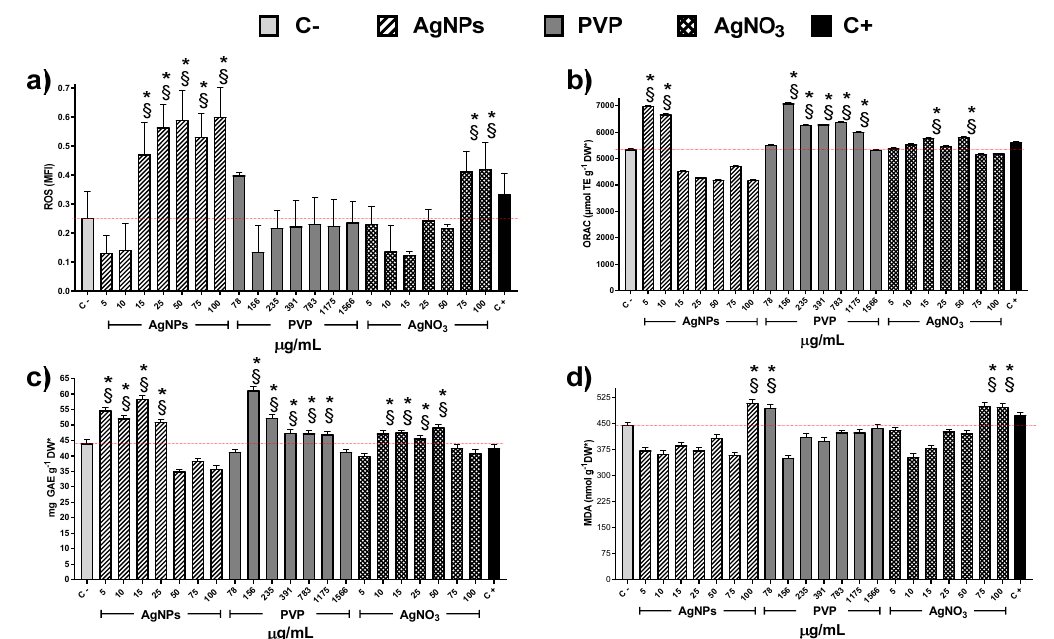
Figure 5. Antioxidant response of Allium cepa roots exposed to different stimuli. ( a ) Reactive Oxygen Species, ( b ) Oxygen Radical Absorption Capacity assay, ( c ) Total Phenolic Content, and ( d ) Lipoperoxidation recorded on the onion roots after 72 h for different concentrations of AgNPs (lined), PVP (dark gray), and AgNO 3 (grid). C- corresponds to untreated plants (light gray) and C+ to those exposed to 0.37 µg/mL of sodium arsenite (black). * Indicates significative differences with the negative control ( p < 0.05); § indicates significative differences with the positive control ( p < 0.05).